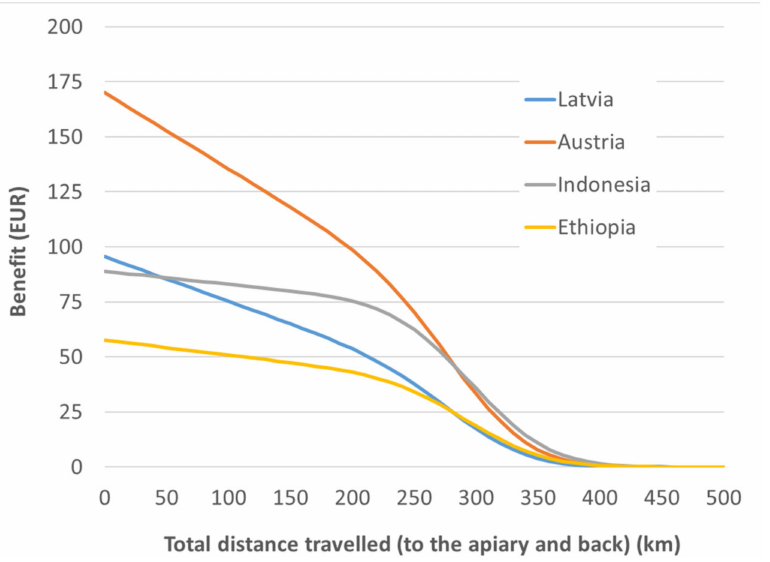
Figure 4. Comparison of the economic benefit of remote swarming detection considering a decrease in swarm catching